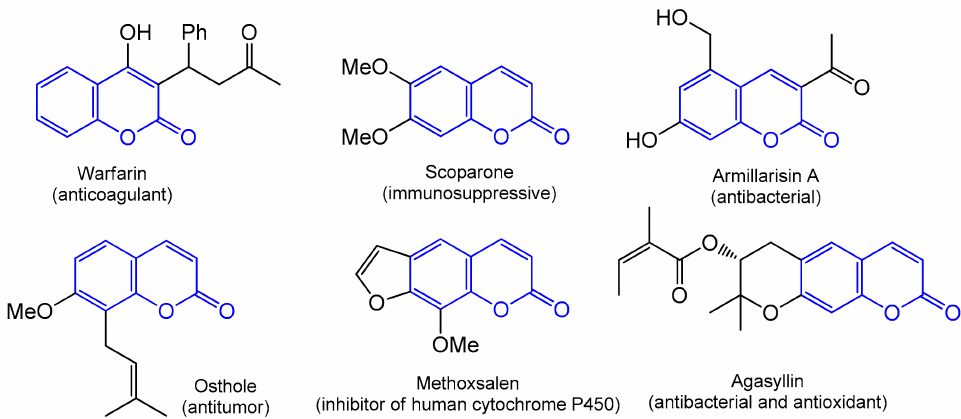
Figure 2. Examples of coumarin skeleton-based